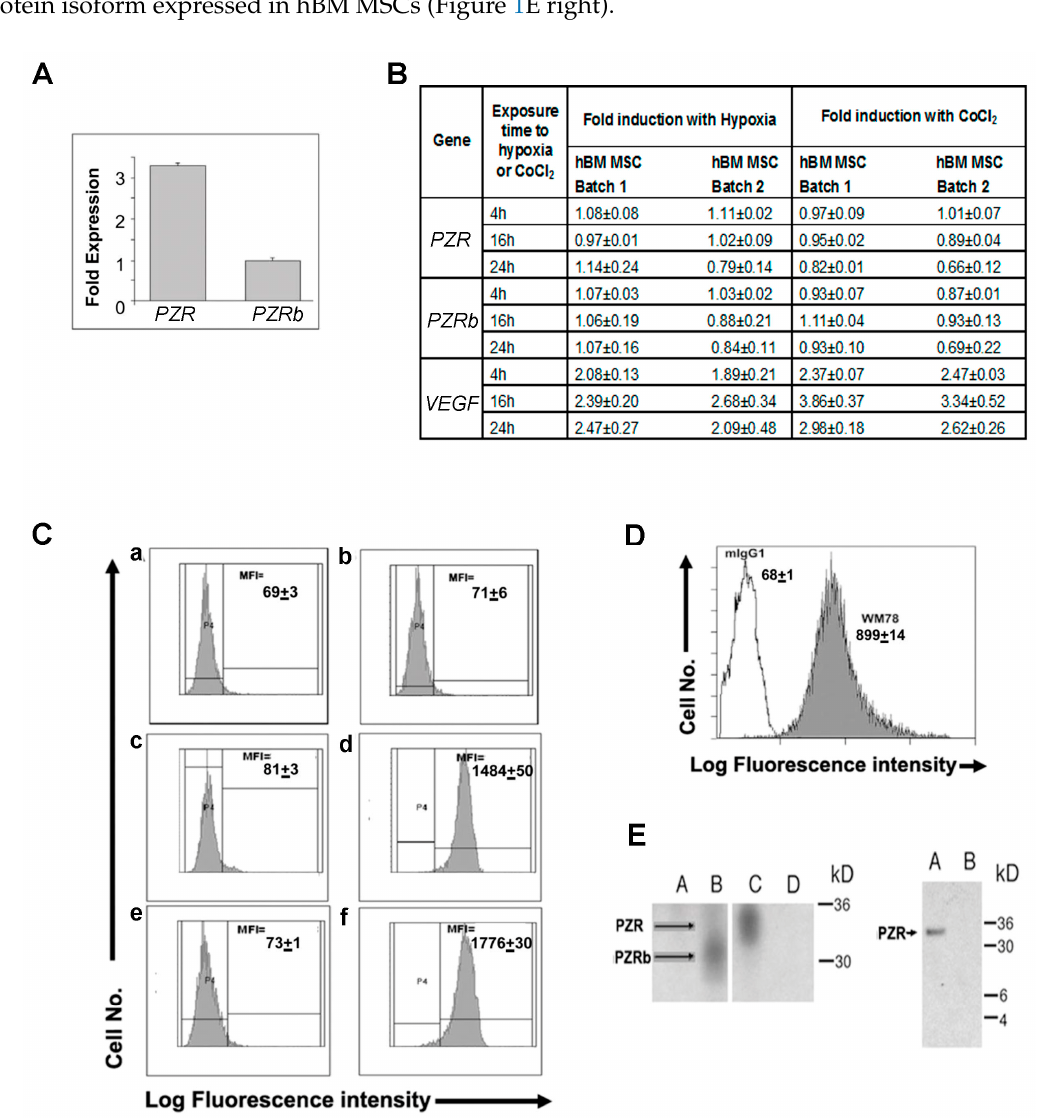
Figure 1. Di ff erential human P 0 -related protein (PZR) and PZRb expression on hBM MSCs. ( A ) Q-RT-PCR of PZR and PZRb using 3 di ff erent hBM MSC batches (mean ± S.E.M.) and human PZR and PZRb primers and probes described in Section 2.5. ( B ) Q-RT-PCR of PZR , PZRb , and the positive control VEGF transcripts in two independent batches of hBM MSC in normoxia (20% O 2 ) with or without 150 µ M CoCl 2 or hypoxia (1.5% O 2 ) for 4, 16, and 24 h. Values are means ± S.E.M. of triplicate assays. ( C ) Flow cytometric histograms of human PZR and PZRb protein expression after mIgG1 (panels a , c , and e ) or WM78 (panels b , d , and f ) staining of MEF cells either untransfected ( a , b ) or expressing hPZR ( c , d ) or hPZRb ( e , f ) plus Alexa-488 goat anti-mouse IgG1 antibody. P2 is the gate